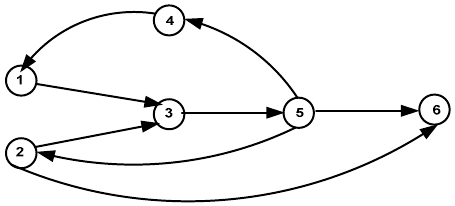
Figure 4. Graph Figure 4. Graph example.